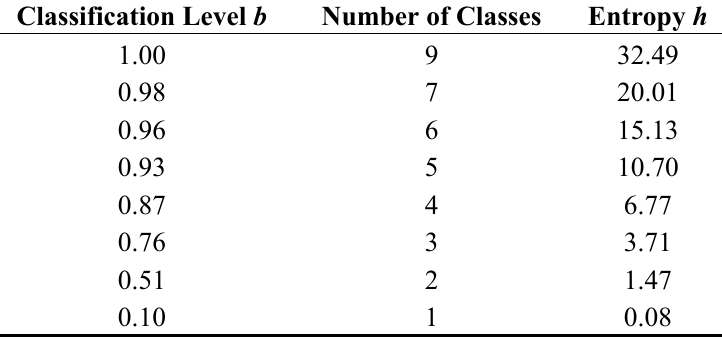
Table 2. Classification level, number of classes and entropy for vector property of